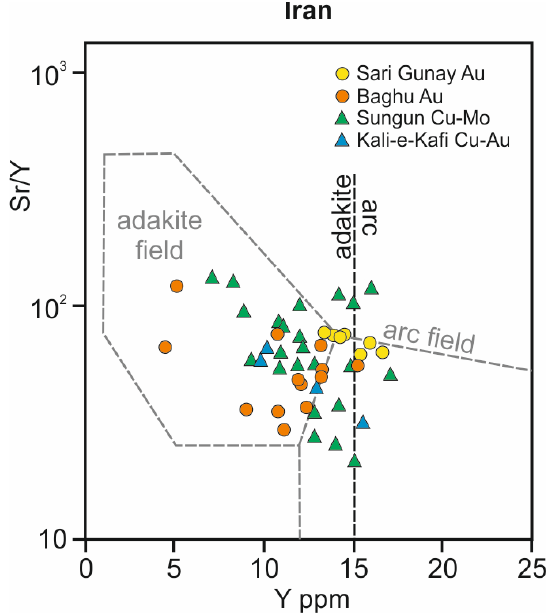
Figure 22. Variations of Sr/Y versus Y (ppm) in igneous rocks associated with porphyry Cu–Au–Mo (triangles) and epithermal Au–Ag (circles) deposits in the Western Tethyan province of Iran. Data sources: Sari Gunay [270]; Baghu [288]; Sungun [286]; Kali-e-Kafi [287].